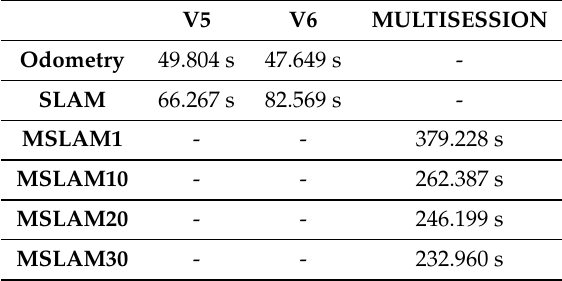
Table 2. Execution times for V 5 and V